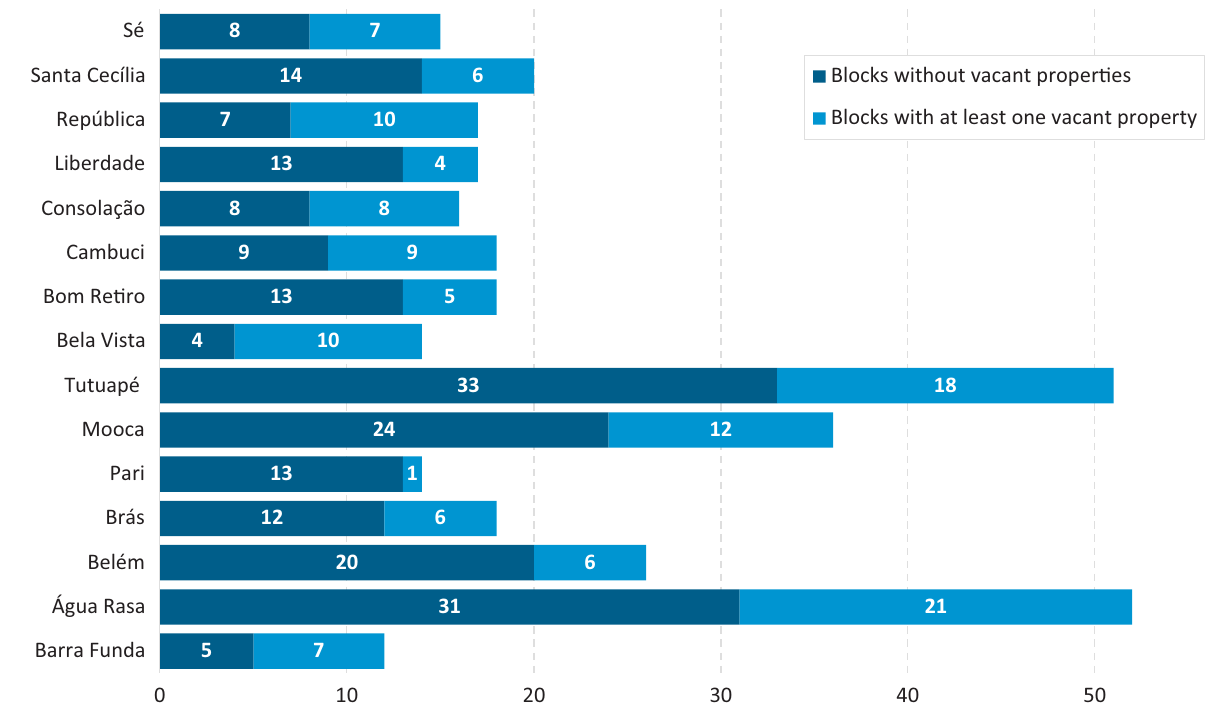
Figure 5. Distribution of blocks with and without vacant properties by